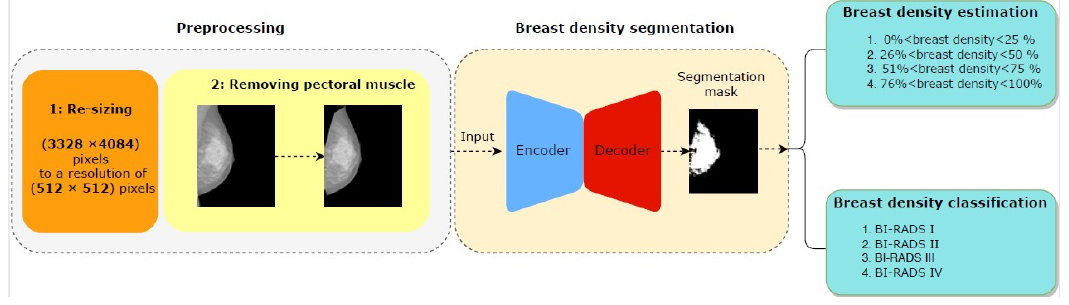
Figure 2. An overview of proposed